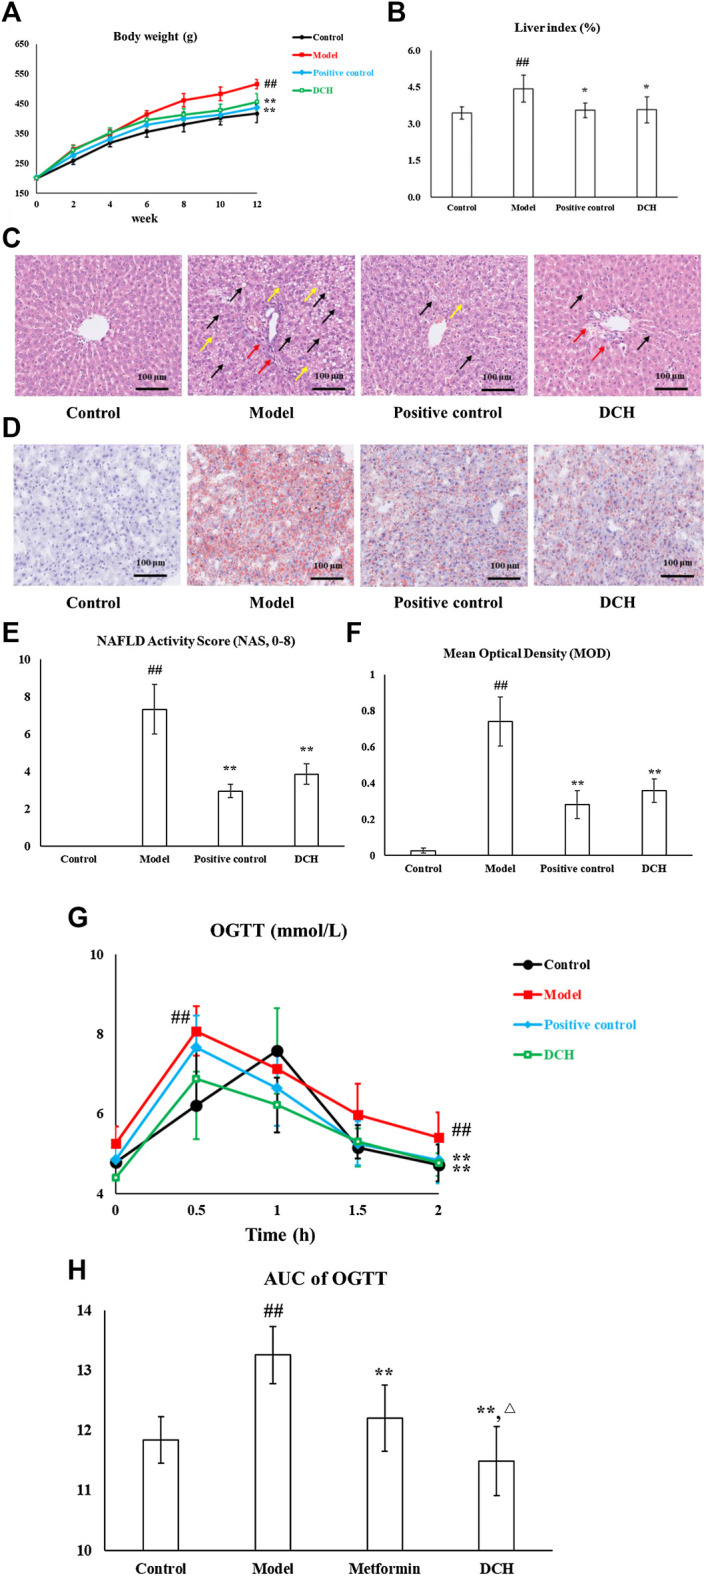
DCH treatment improved the hepatosteatosis, IR and oxidative stress in NAFLD model rats. (A,B) DCH treatment decreased the body weight and liver index in NAFLD model rats. (C,E) H&E staining showed that DCH treatment ameliorated the hepatic steatosis, hepatocytes ballooning, and lobular inflammation in the liver. Black arrows indicate the steatosis of hepatocytes, red arrows indicate lobular inflammation and yellow arrows indicate hepatocyte ballooning (×200 magnification). (D,F) Oil Red O staining shows that DCH treatment improved the lipid accumulation in the liver (200×). (G,H) The AUC of OGTT was decreased in NAFLD model rats after DCH treatment. Control, model, positive control and DCH (n = 10 per group) groups. Data are presented as the mean ± SD. ##: p < 0.01 as compared to the control group; *: p < 0.05 as compared to the model group; **: p < 0.01 as compared to the model group; △: p < 0.05 as compared to the positive control group.